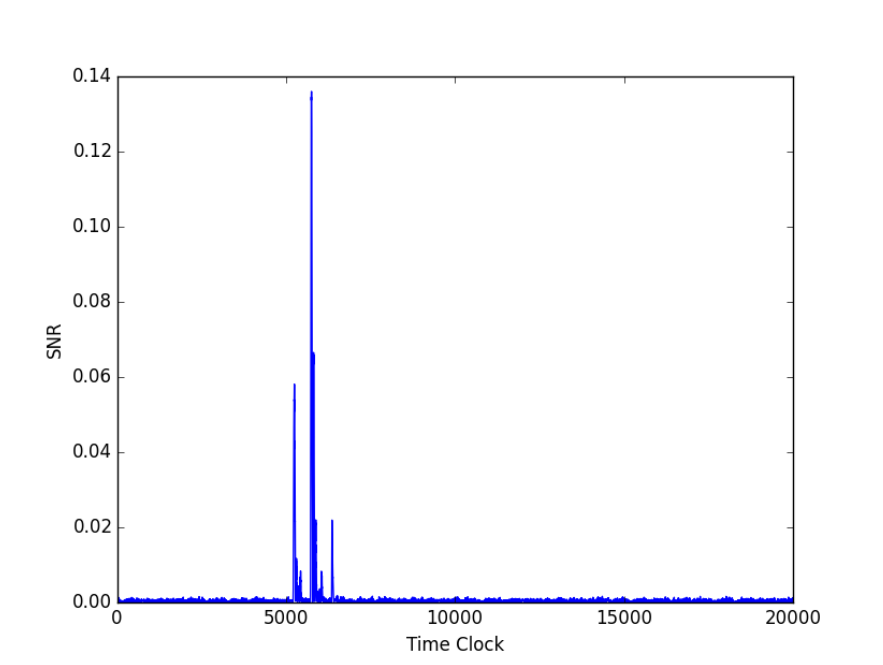
Figure 10: SNR of the first Sbox for the first round of